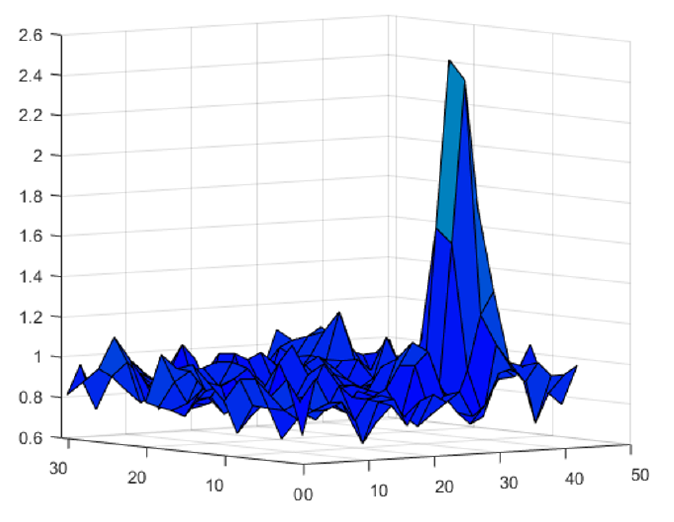
for the point impact for three sensor i , j